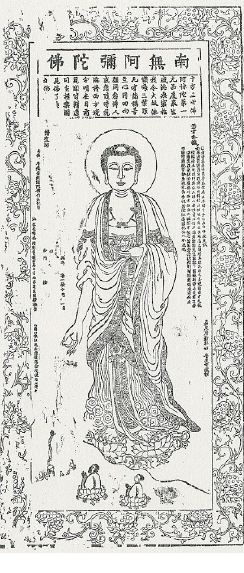
Figure 6. Descent of Amitabha (Ch. Amituo laiyingtu ), late Ming–early Qing, 150.0 × 50.5 cm, The